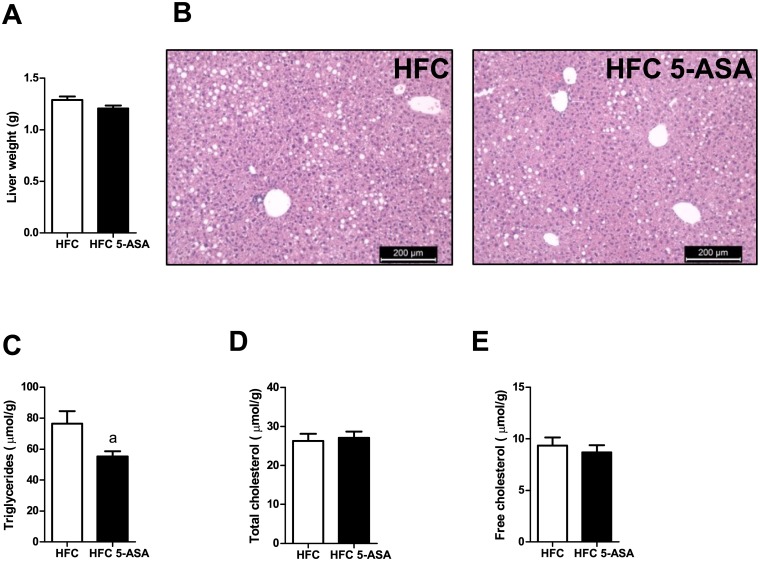
5-ASA treatment alleviates hepatic lipid accumulation during HFC feeding.(A) Liver weights were measured on sacrifice day after 12 weeks of HFC or HFC 5-ASA. (B) Histology of liver after 12 weeks of either HFC or HFC 5-ASA diet (H&E stain; 100×). (C-E) Hepatic triglycerides, total cholesterol and free cholesterol levels of HFC or HFC 5-ASA-fed mice. Data are presented as means ± SEM, n = 9–10 mice, aP < 0.05 vs. HFC.